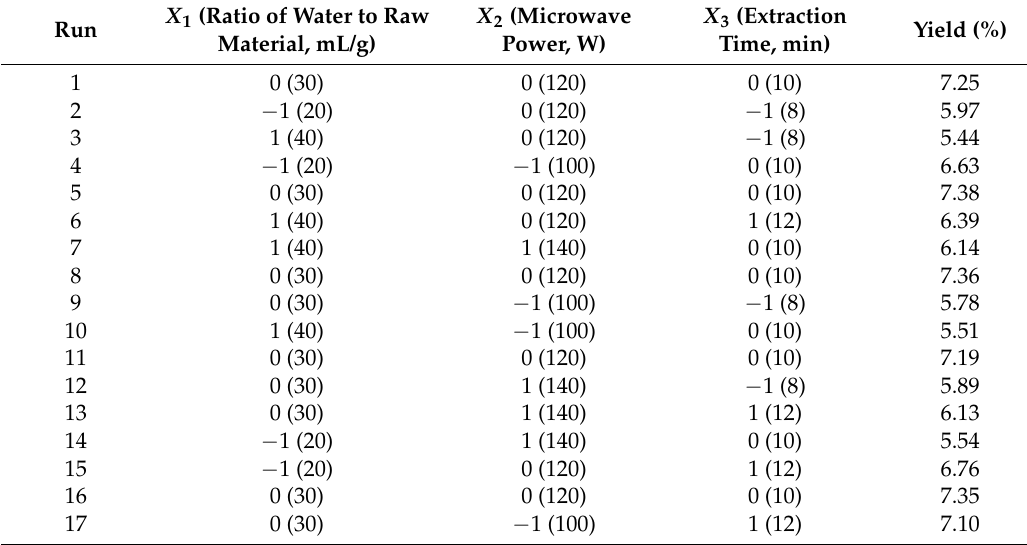
Table 1. The Box-Behnken design matrix and the results for extraction yield of T. orientalis polysaccharides. X 1 (Ratio of Water to Raw X 2 (Microwave Run Material, mL/g) Power,